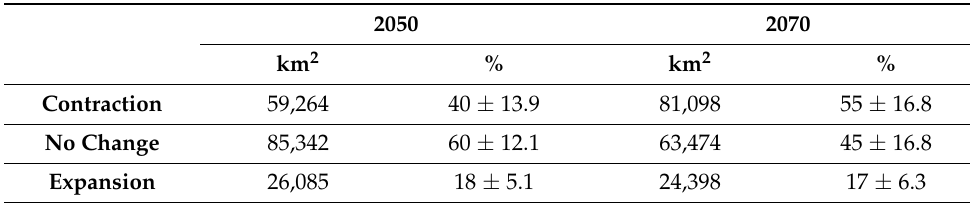
Figure 3. Environmental suitability for E. obliqua in Tasmania as determined by an ensemble of 3 SDMs (Maxent, MARS and ANN) under historical (1960–1990) and projected future climates for mid (2041–2060) and end of century (2060–2081) according to global climate models ACCESS1.0, CNRM-CM5 and MIROC5, with ensemble mean of the three GCMs for each time period. Table 4. Change in species range for E. obliqua according to the mean of 3 SDMs (Maxent, MARS and ANN) and 3 GCMs (ACCESS1.0, CNRM-CM5 and MIROC5) as a percentage of initial distribution and areal extent (km 2